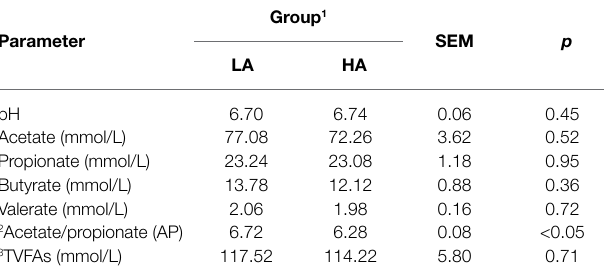
TABLE 3 | Parameters of rumen fluid fermentation in Sanhe heifers at different altitudes.